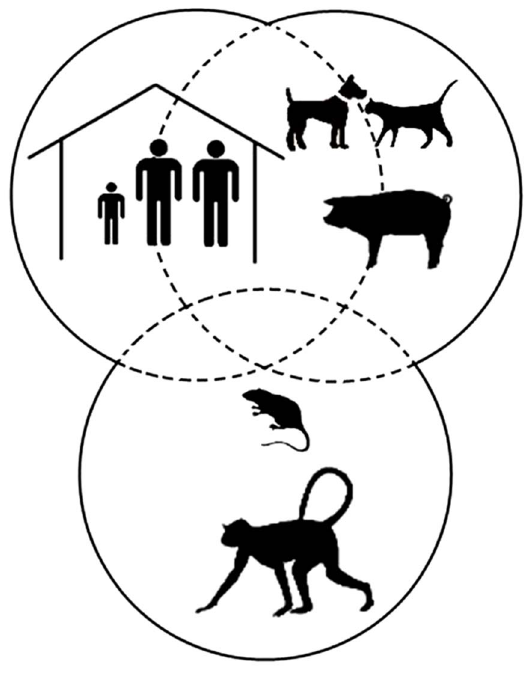
Figure 2. Life cycle of T.penetrans in a tropical environment. The human, domestic, and sylvatic cycles overlap closely.